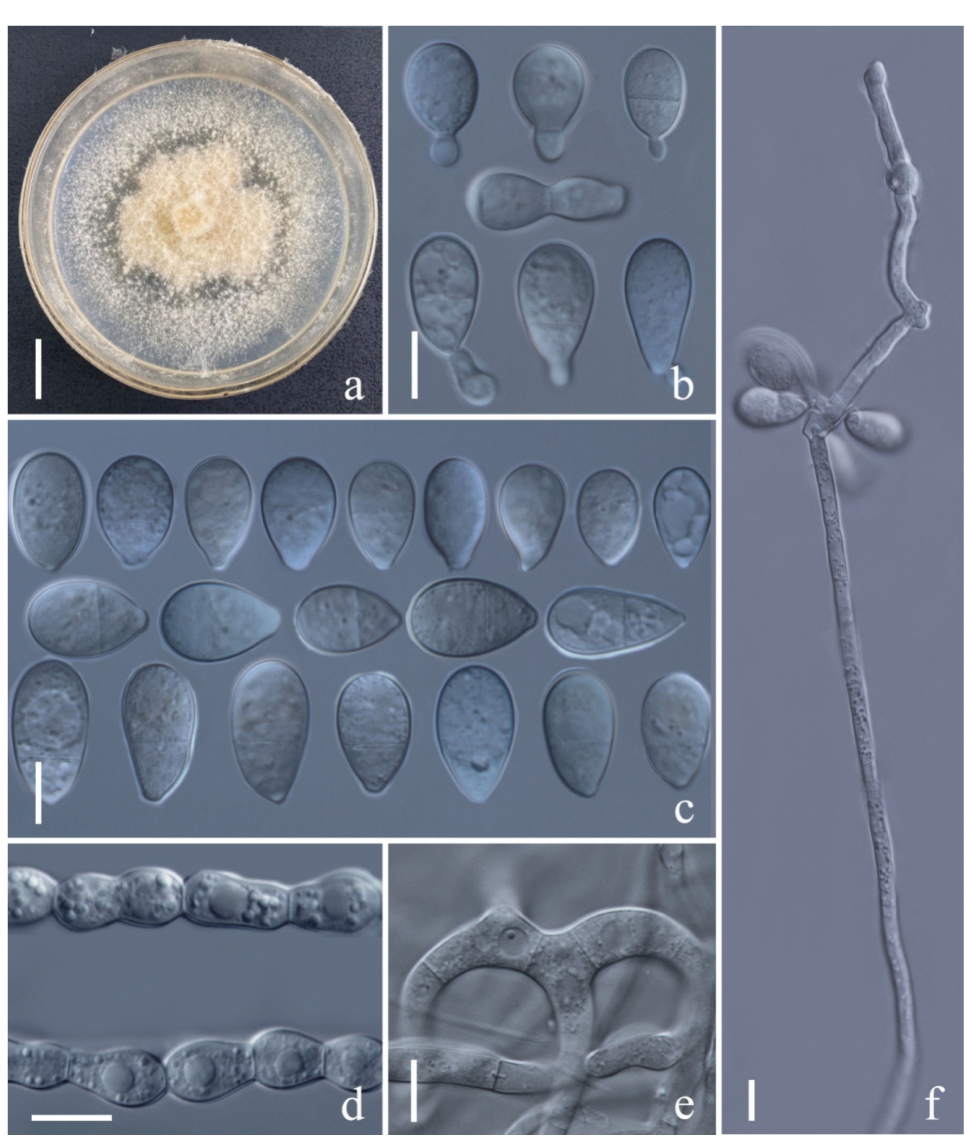
Figure 3. Arthrobotrys jinpingensis (CGMCC3.20896). ( a ) Colony. ( b , c ) Conidia. ( d ) Chlamydospores. ( e ) Trapping device: adhesive networks. ( f ) Conidiophore. Scale bars: ( a ) = 1 cm, ( b – f ) = 10 µ